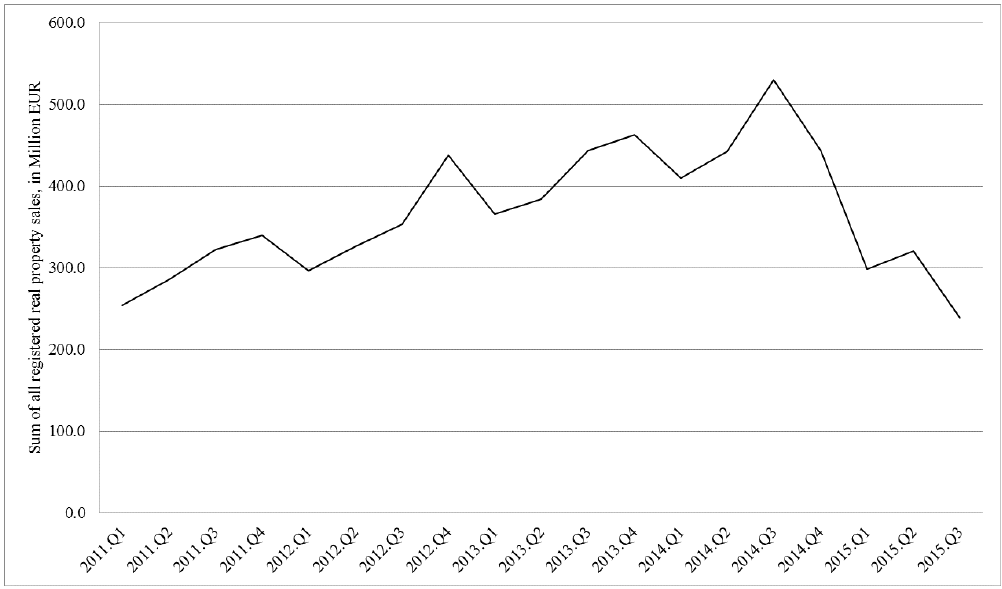
Fig. 2. Quarterly sum of all real property sales deals in Latvia from 2011 Q1 to 2015 Q3. Deals registered in the Land Registry of Latvia until 30.12.2015. (developed by the authors based on the data of the State Land Service of